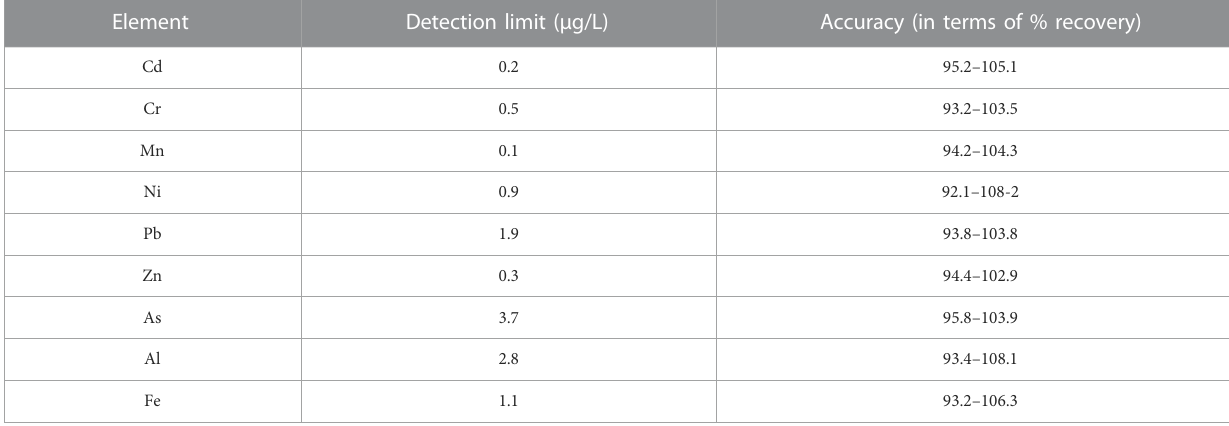
TABLE 1 Detection limits and accuracy details for heavy metal